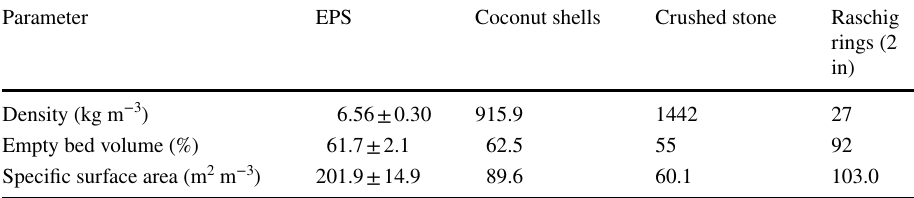
Adapted from Henley and Seader (2005), Daigger and Boltz (2011), Lemji and